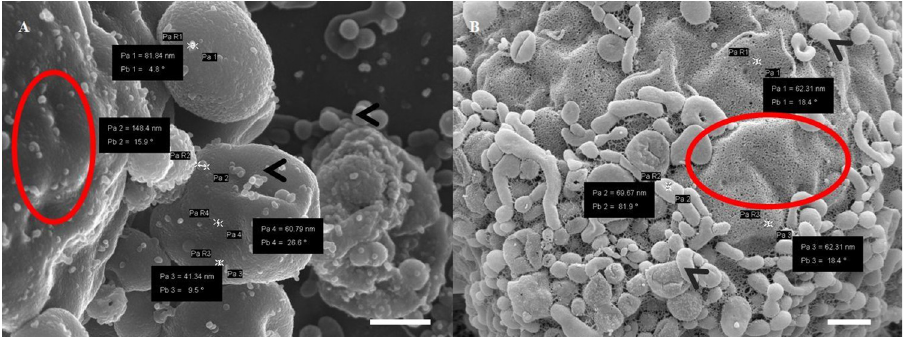
Fig 6. A micrograph representing BEC plasma membrane (PM) surfaces. (A) An image of carbon-coated PM and microvesicle (MV) formation. Scale bar = 1000 nm; (B) An image of a Au:Pd coated PM and vesicle formation. Scale bar = 200 nm. The “red circles” indicate distinct differences in the PM: (A) shows a smooth membrane surface, devoid of pores; (B) displays a porous membrane surface. Pore sizes range between 62–70 nm. The “black arrows” indicate the formation of microvesicles (A) reveals smooth vesicles; (B) exhibits textured vesicles on the PM